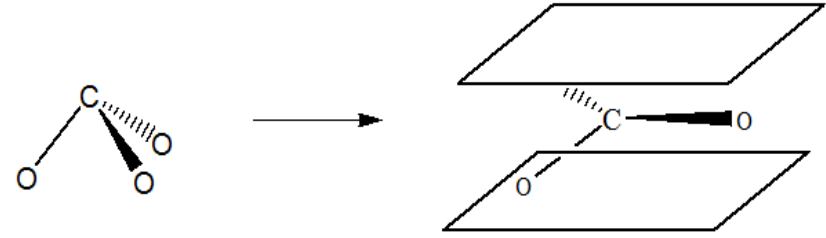
Figure 2. Schematic picture of LDH “Ref. [6]” .